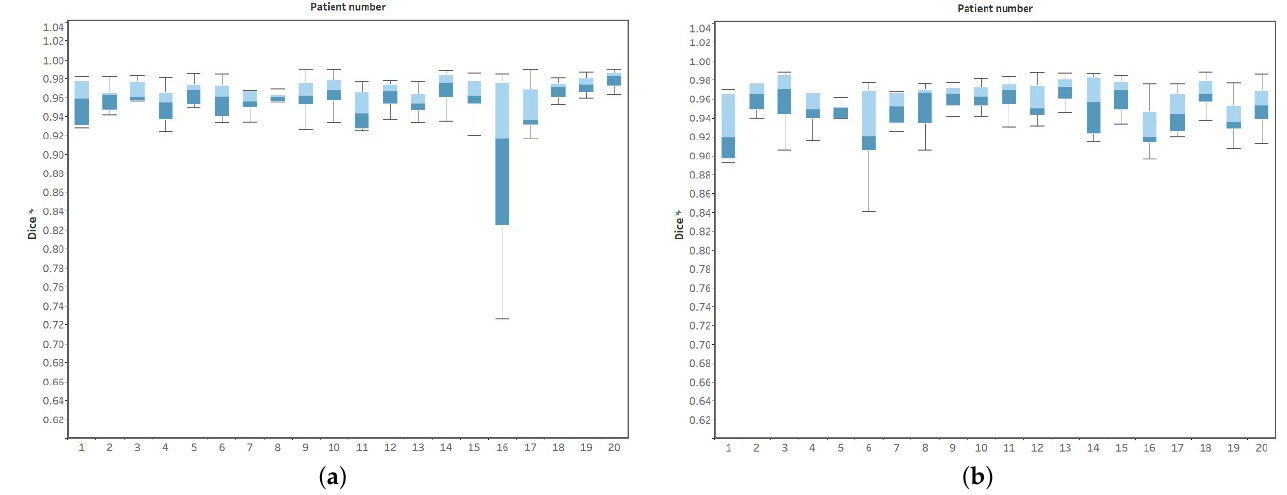
Figure 7. Box plot of Dice coefficients on Sliver07 and 3Dircadb: ( a ) Dice coefficients on Sliver07; ( b ) Dice coefficient on 3Dircadb.